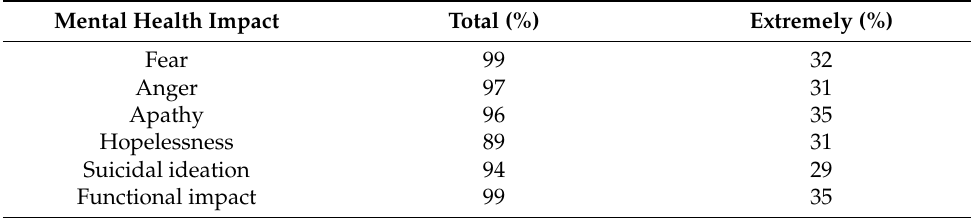
Table 2. Mental health impacts on people in the Moria